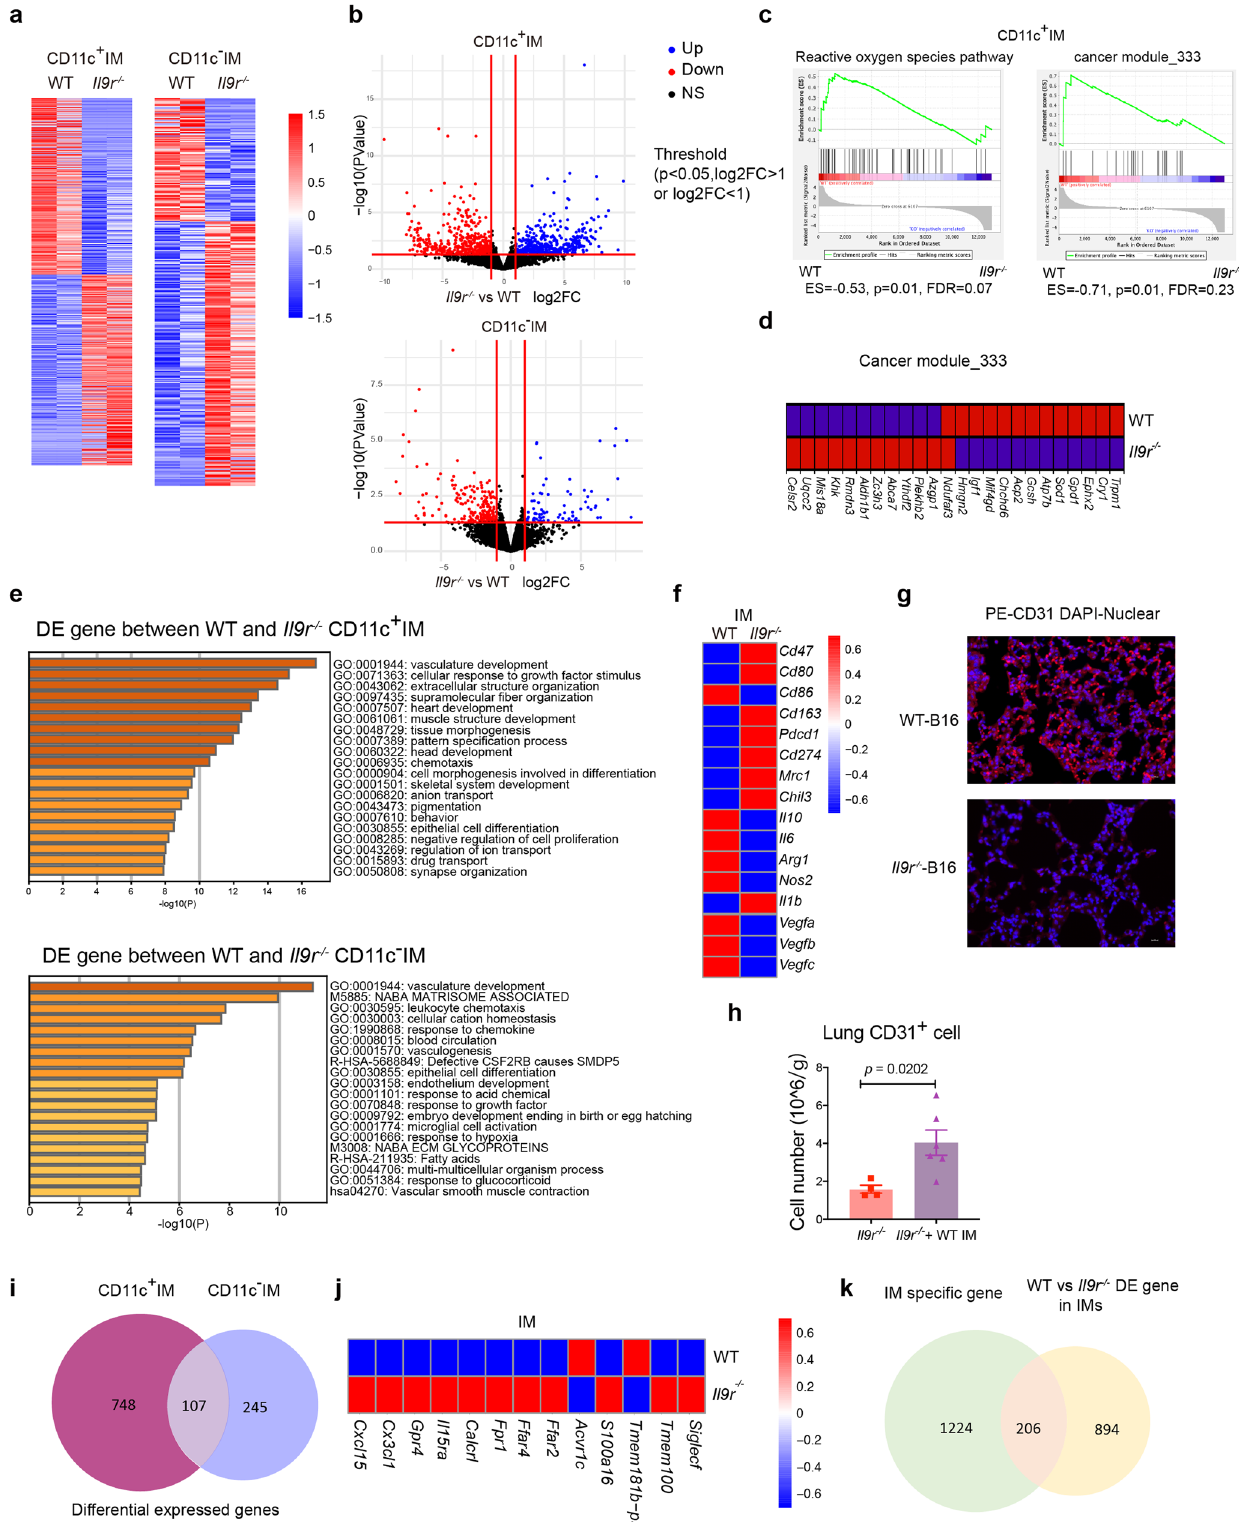
available data, we found increased IL9R expression in lung tumor tissue compared to normal lung tissue (Fig. 9c). IL6 expression was also increased in lung tumor tissue compared to normal lung tissue (Fig. 9c). Lung cancer patients also showed increased concentrations of serum IL-9, IL-6, and enhanced arginase activity (Fig. 9d). Compared to macrophages in normal